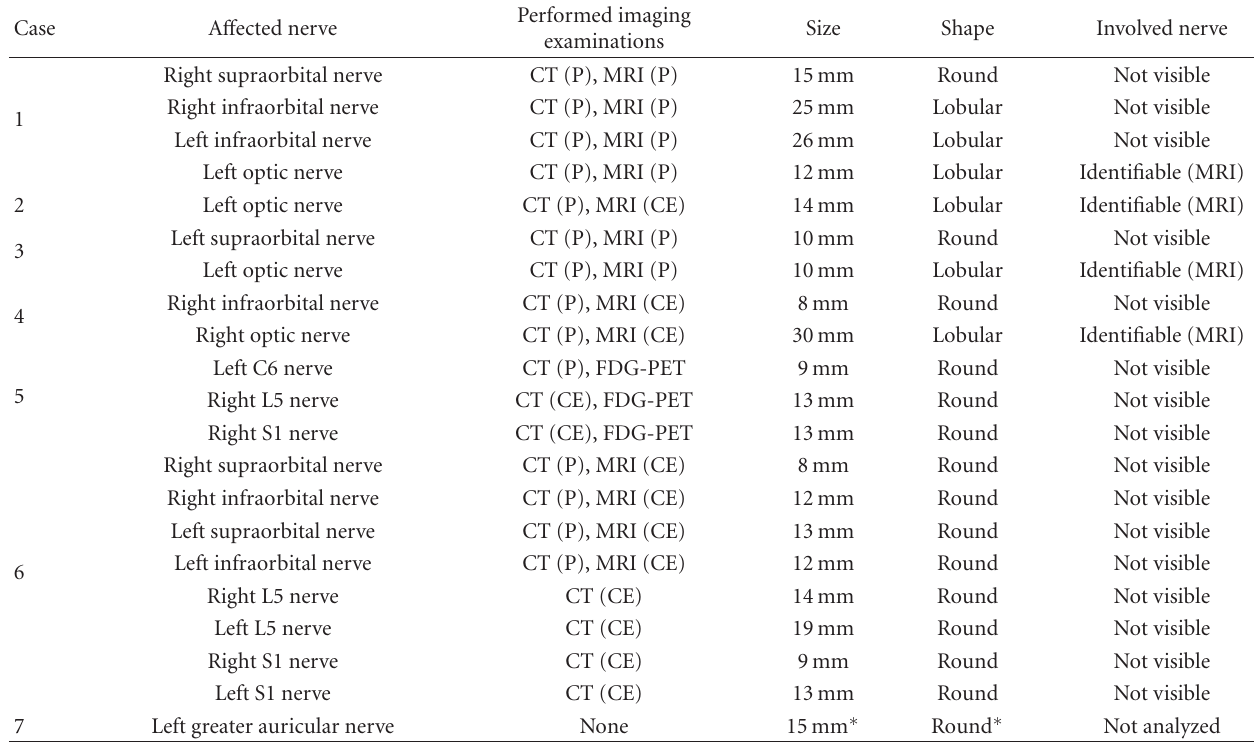
Table 3: Characteristics of perineural